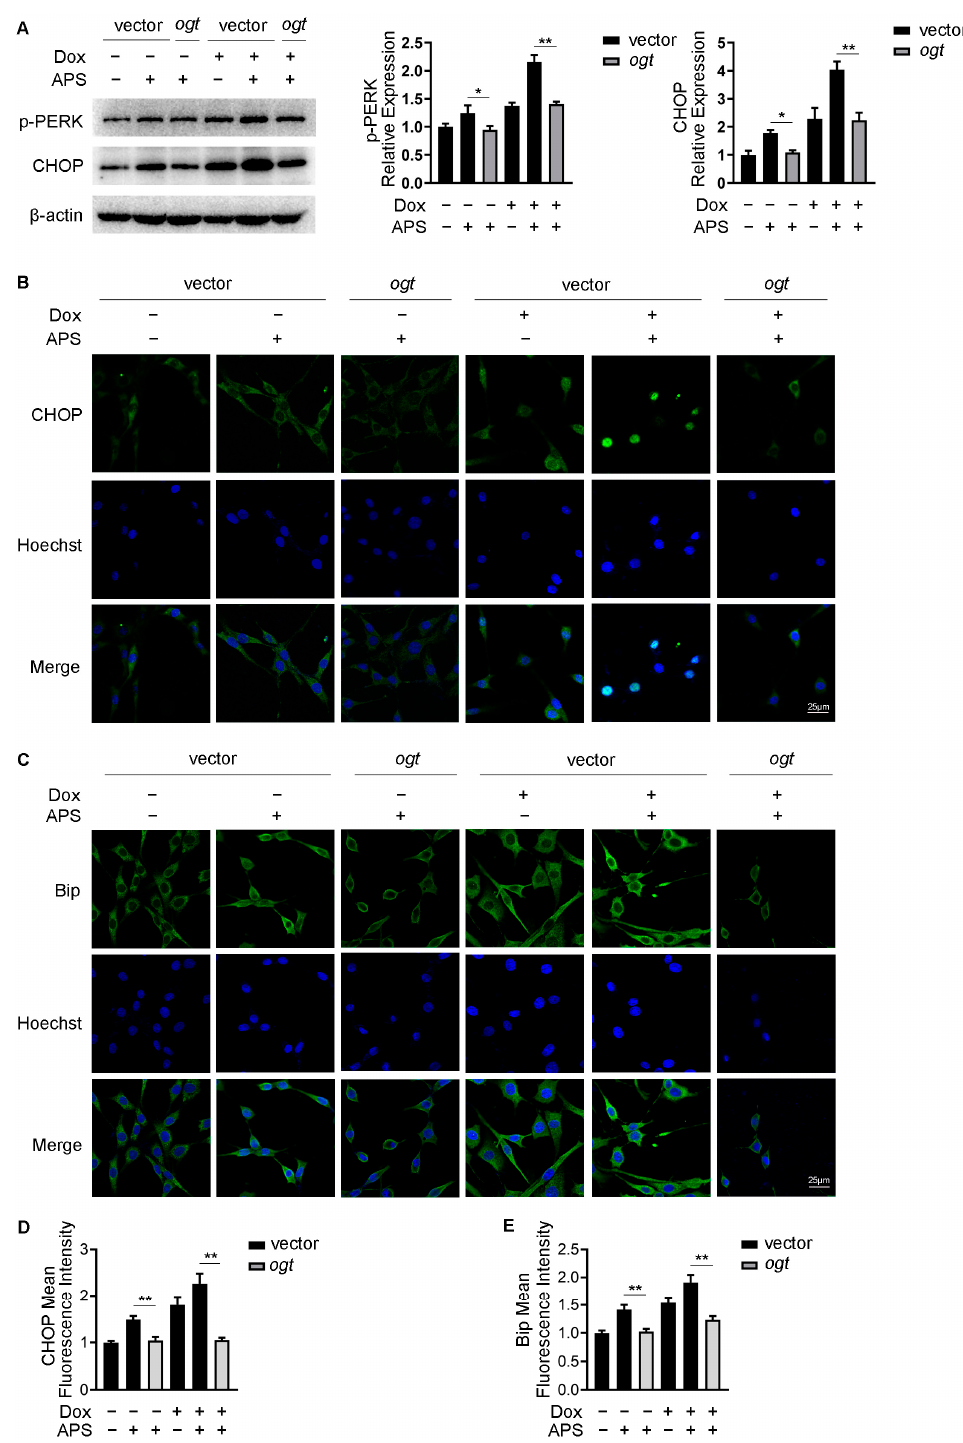
Figure 4. APS exacerbates ER stress response by reducing O-GlcNAcylation in Hep3B cells. Hep3B cells were transfected with lentivirius carrying vector control or ogt followed by treating with or without 50 mg/L APS, in the absence or presence of 1 µ M Dox. Then, cells were subjected to ( A ) Western blot analysis for p-PERK and CHOP, and immunofluorescence for ( B ) CHOP and ( C ) Bip. Images presented are representative of each group. Mean fluorescence intensity of ( D ) CHOP and ( E ) Bip were calculated using IPP software. Scale bar, 25 µ m. Five random visual fields were measured for each sample. Data are expressed as mean ± SEM from three independent experiments. *, p < 0.05, **, p <